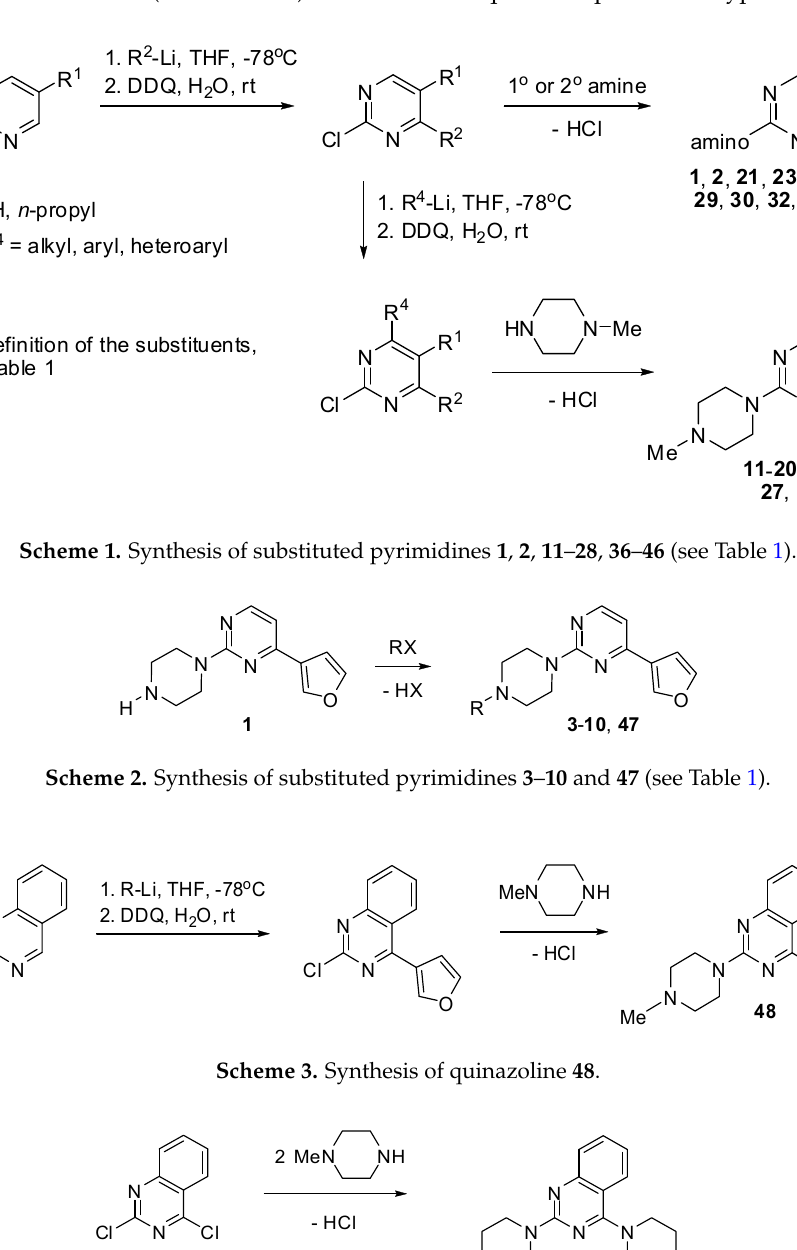
Scheme 4. Synthesis of quinazoline 49 .